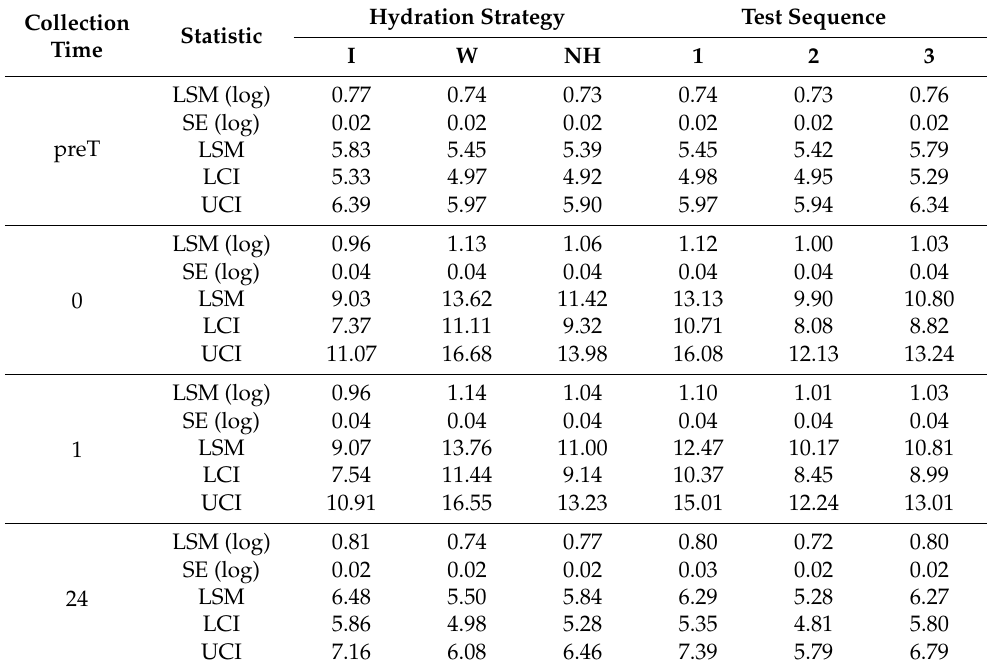
Table 13. Results for WBC [10 3 /mm 3 ] measured before the test (preT) and 0, 1, and 24 h after the test performed for different hydration strategies in three consecutive tests: marginal means (LSM); standard errors (SE) for values after logarithmic transformation (log); and marginal means and upper (UCI) and lower (LCI) confidence intervals restored to original